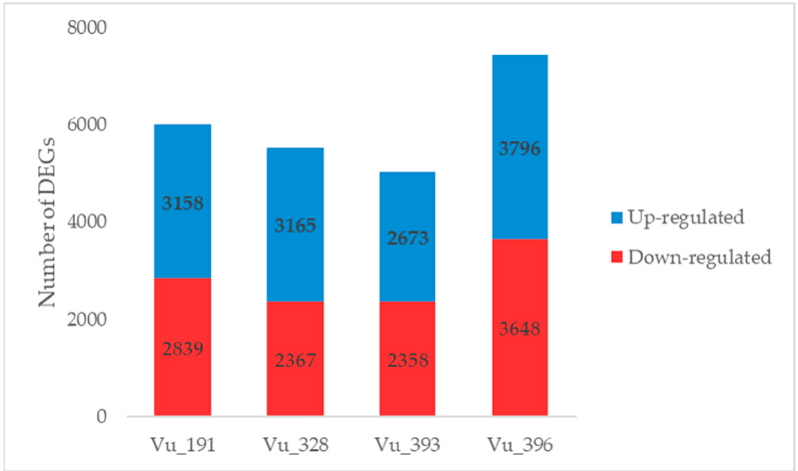
Figure 3. Number of DEGs identified in a comparison between the control and NaCl treatment for cowpea germplasms with different levels of salt tolerance.